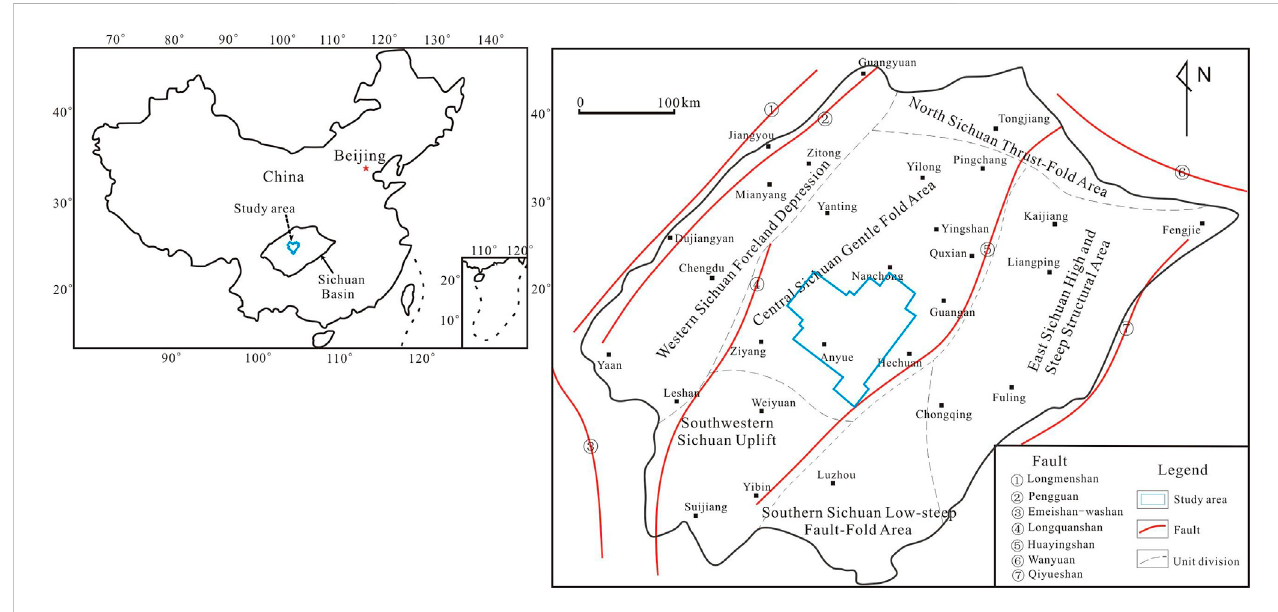
FIGURE 1 Structural location of the study area (modi fi ed according to Tan et al.,